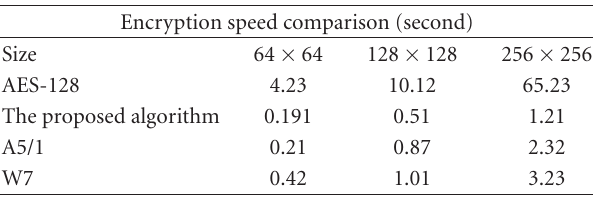
Table 6: Compare the speed of the studied algorithms in MATLAB programming